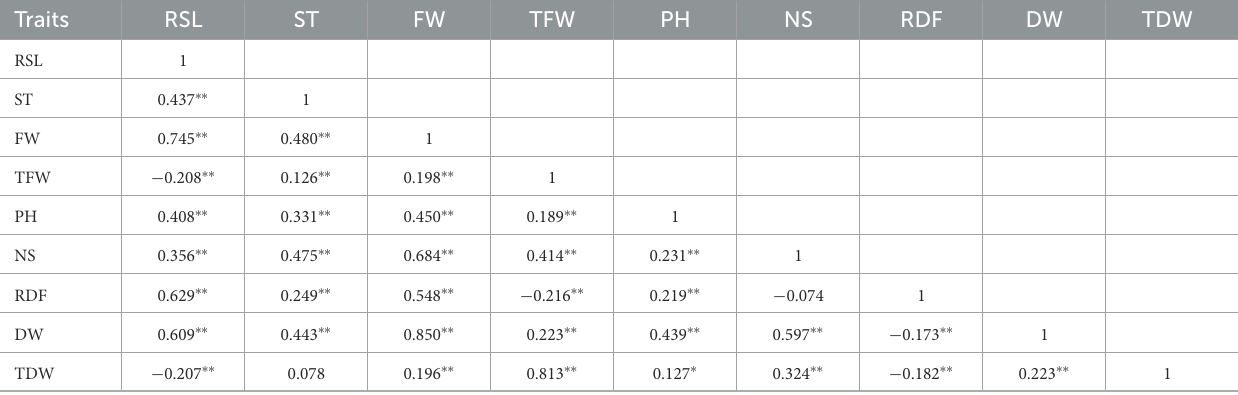
TABLE 8 Correlation coefficients of phenotypes ( rp ) among 44 varieties of alfalfa in 2020.